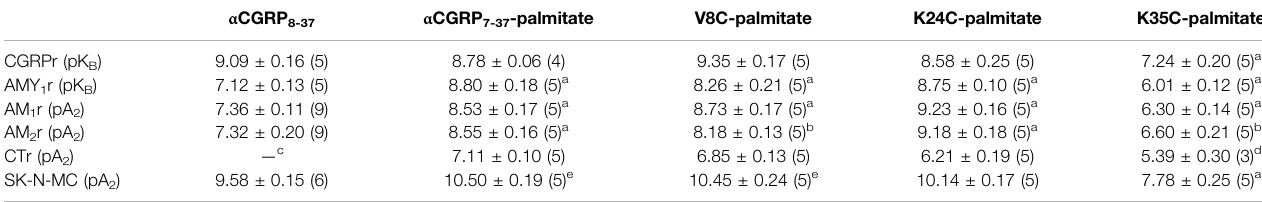
TABLE1| Antagonistactivitiesoflipidated α CGRP 8-37 analoguesatcalcitonin-familyreceptorsexpressedinCos-7cellsorSK-N-MCcellswithendogenousCGRPreceptor expression. α CGRP α CGRP 8-37 7-37 -palmitate V8C-palmitate